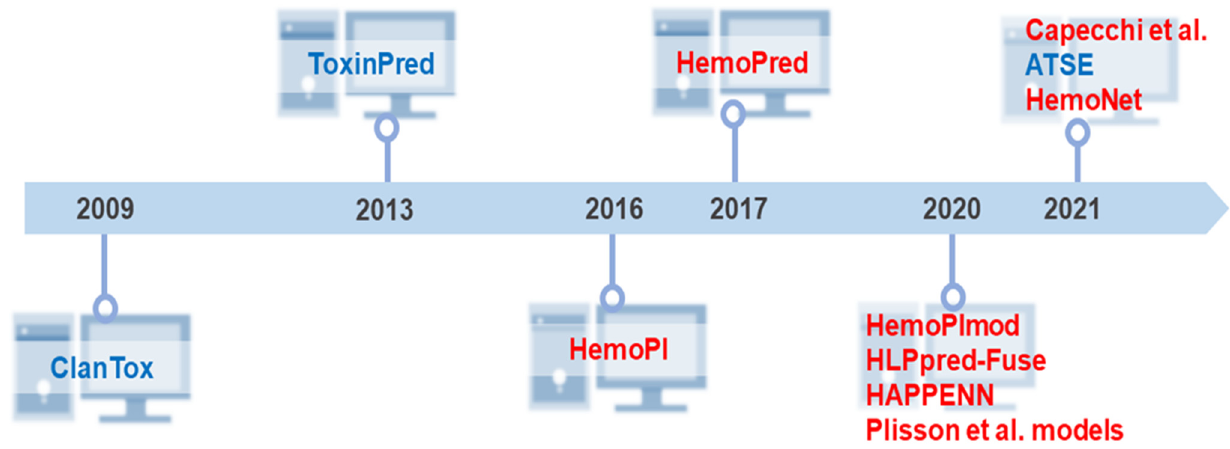
Figure 3. Historical overview of the development of freely available tools and models for prediction of peptide toxicity. Big biomedical peptide data have been explored to design new predictive methods that facilitate adequate access to the full potential of peptides. Despite the many years of peptide science, our literature review demonstrates that these in silico approaches are relatively new. From the pioneering and innovative ClanTox [112] and ToxinPred [40] launched in 2009 and 2013, respectively, ten high-throughput computer toxicity prediction tools were developed that mainly predict peptides’ hemolytic effects. Most of them have been released in the last 5 years. Capecchi et al. [38] and HemoNet [113] are the latest hemolytic classifiers. Some predictors such as HAPPENN [36] and HemoPI [26] have more than one version. HemoPI has 5 SVM methods, while HAPPENN is composed of 3 methods. However, due to the difference in performance reported by the authors, for this chronology, we considered only the best-in-class performance methods. The three Plisson models [37] were considered due to high similarity in performance metrics. Peptide toxicity predictors are highlighted in blue, and the classifiers for predicting peptides’ hemolytic activity are colored in red.